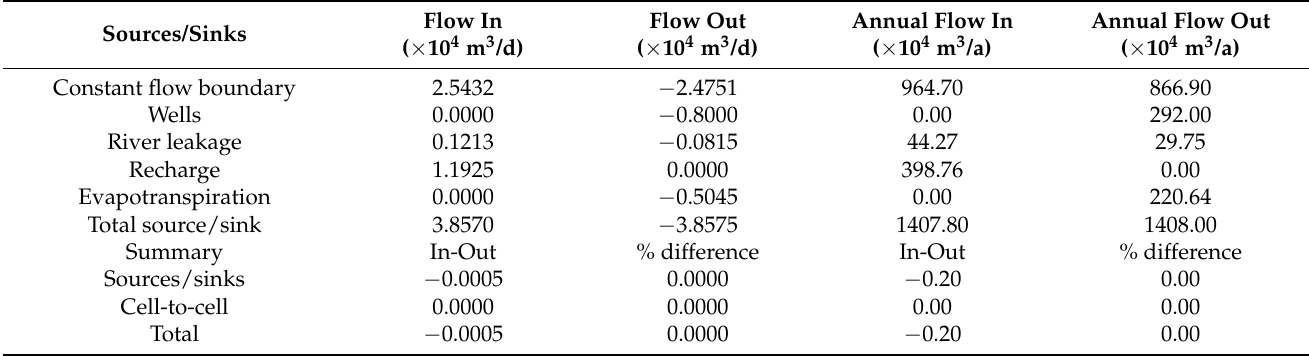
Table 3. Summary of total MODFLOW simulation groundwater flow